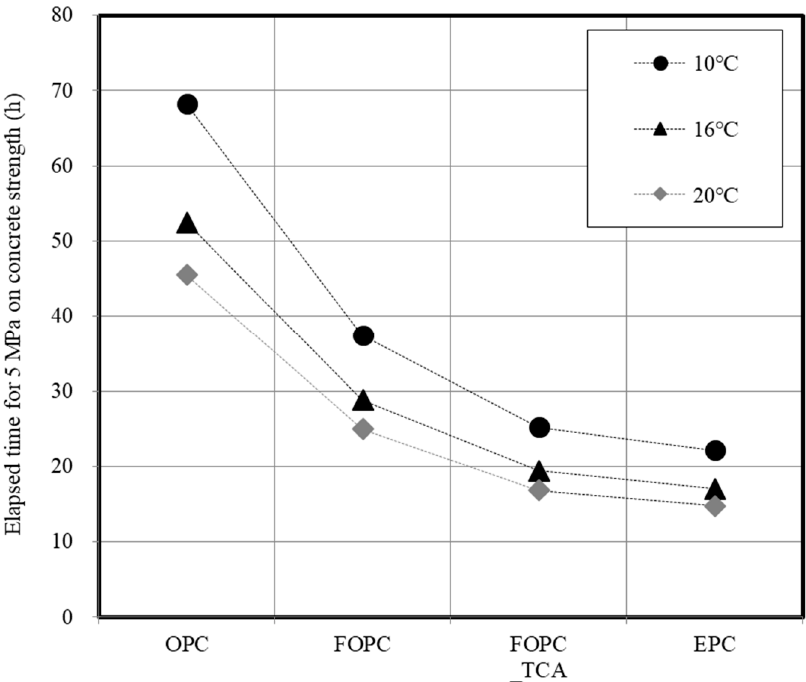
Figure 13. Elapsed time for development of 5 MPa strength in concrete using maturity method for di ff erent curing temperatures.